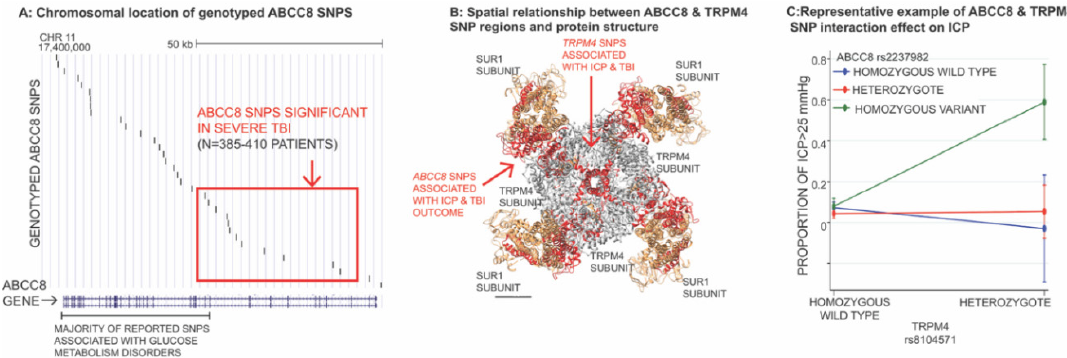
Figure 5. ABCC8 and TRPM4 genetic variation may impact edema, intracranial hypertension, and outcome post-TBI. ( A ) Chromosomal location of genotyped ABCC8 single nucleotide polymorphisms (SNPs). Graphical display of the chromosomal location of sequenced (black lines) vs. significant (red box) SNPs as plotted on the UCSC genome browser (version GRCh38/hg38). The ABCC8 gene is shown in blue, with vertical lines representing individual exons (and the interspersed horizontal lines representing introns) All the significant SNPs identified in TBI are upstream (introns 2–15) whereas the majority of SNPs significant in disorders of glucose metabolism (annotated in black) are downstream. Scale bar of 50 kb is shown. Adapted with permission from Jha et al., 2018. ( B ) Spatial relationship between ABCC8 and TRPM4 SNP regions and protein structure. This three-dimensional structure was created from UCSF Chimera automated software, combining the known crystallized structure of SUR1 (Li et al., obtained from the Research Collaboratory for Structural Bioinformatics Protein Data Bank [RCSB-PDB] using the ID 5WUA), with TRPM4 (Autzen et al., obtained from the RCSB-PDB using the ID 6BQV). In the putative octameric structure, the four SUR1 subunits are brown and the four TRPM4 subunits are gray. Amino acid sequences highlighted in red are those encoded by regions of TRPM4 DNA (in proximity to rs8104571 and rs150391806), and those encoded by DNA regions in linkage disequilibrium with the eight significant ABCC8 SNPs in TBI. ( C ) Representative example of ABCC8 and TRPM4 SNP interaction effect on ICP. This graph demonstrates the direction and magnitude of the interaction effect on ICP between TRPM4 rs8104571 and ABCC8 rs2237982. Here, patients homozygous wild-type for TRPM4 rs8104571 have almost no proportion of their ICP measurements recorded at > 25 mmHg regardless of their ABCC8 rs2237982 genotype. This is also true for patients heterozygous for TRPM4 rs8104571 who are also wild-type for ABCC8 rs2287982 (blue). Those who are heterozygous for TRPM4 rs8104571 and are also heterozygous for ABCC8 rs2287982 SNPs (red) have an average of ~5% of their ICP measurements recorded at > 25 mmHg. However, patients who are both heterozygous for TRPM4 rs8104571 and homozygous-variant for ABCC8 rs2237982, have an average of ~60% of their ICP measurements recorded at > 25 mmHg. Similar interaction effects between TRPM4 rs8104571 and all three significant ABCC8 SNPs in intron 10 (not shown) were obtained for multiple measures of ICP (including peak, average ICP values). Adapted with permission from Jha et al., 2018.